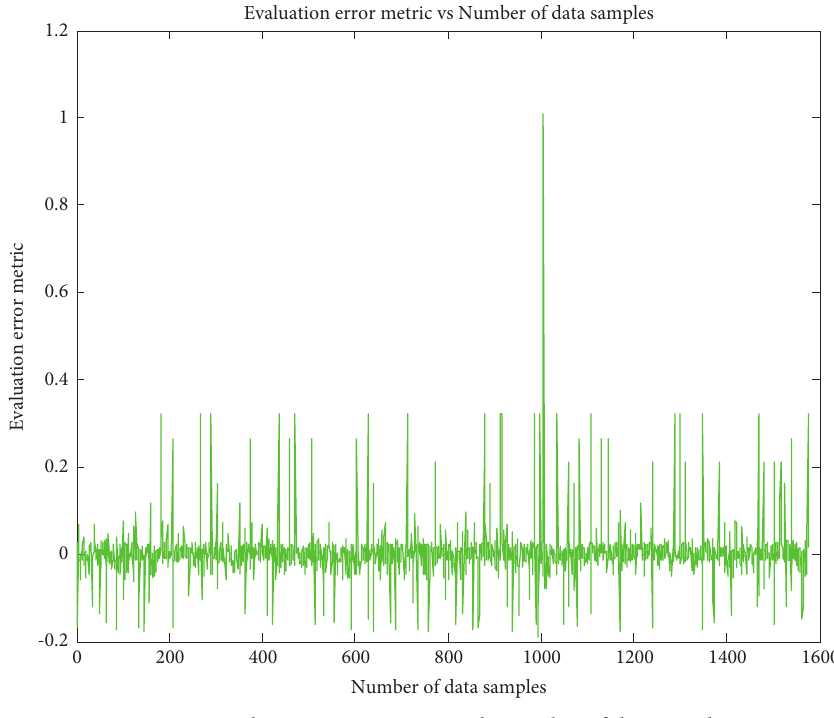
Figure 12: Evaluation error metric vs. the number of data samples.